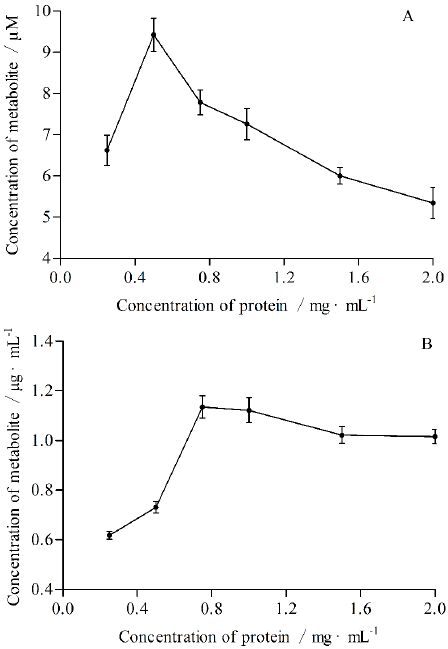
Figure 2. Influences of protein concentrations on the production rates of 4-nitrocatechol ( A ) and 6 β -hydroxytestosterone ( B ).